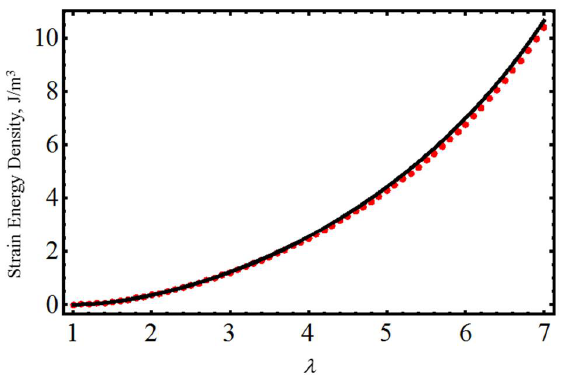
Figure 1. Comparison between the experimental strain energy density and the theoretical predictions obtained from Equations (8) and (16). Here, the red dots represent the experimental data, while the black solid line describes the theoretical predictions. The experimental data was adapted from